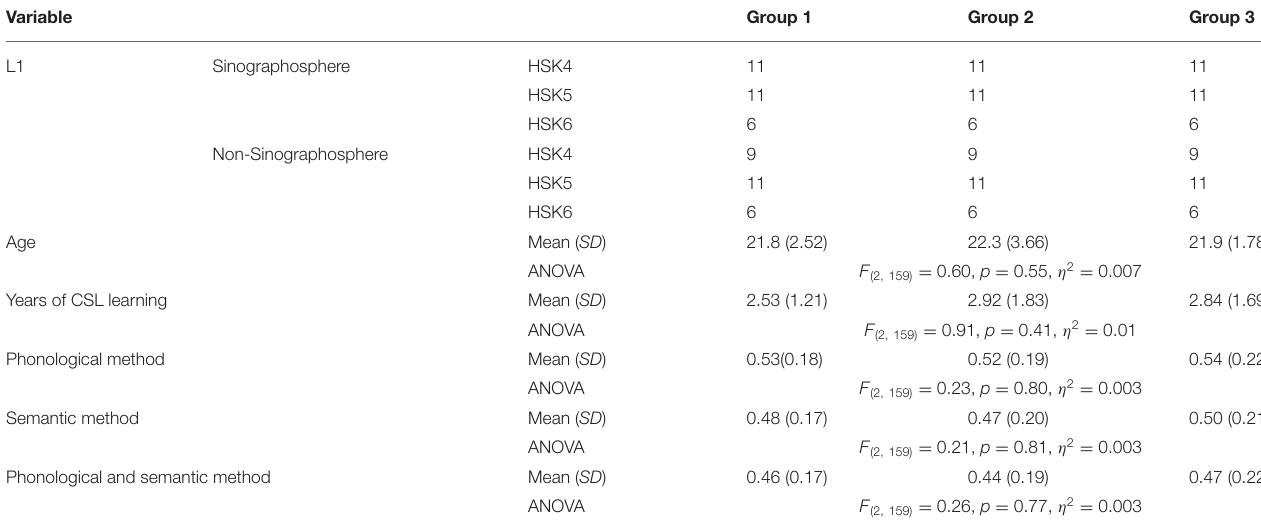
TABLE 6 | Summary of the three randomly selected groups. Variable